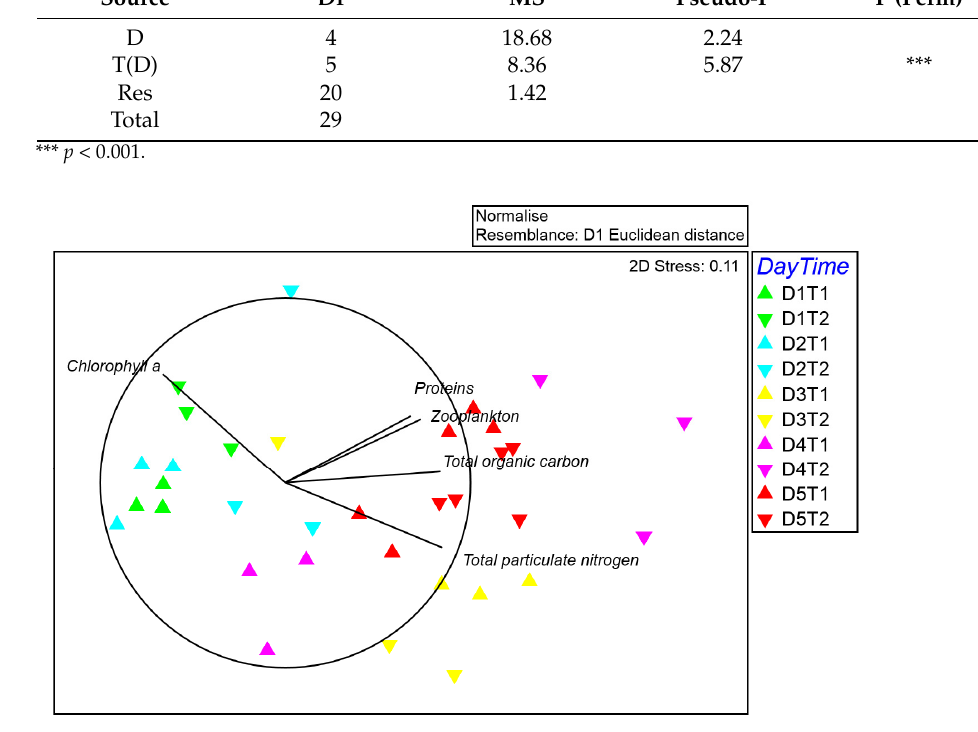
Figure 2. Multidimensional scaling (MDS) plot for seston composition with Euclidean distances based on normalized data; vectors with Pearson’s correlation coefficients display environmental variables.